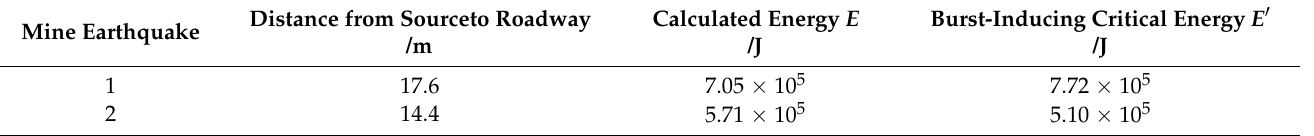
Table 7. Mine earthquake source parameters and burst-inducing critical